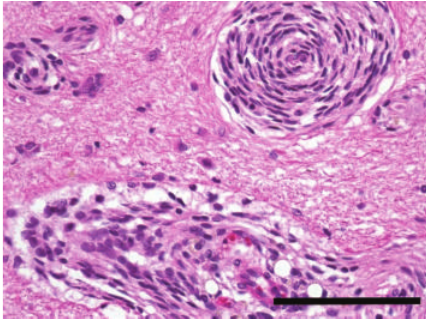
Figure 6: Perivascular wall tumor; right piriform lobe. Higher magnification demonstrating perivascular whorling of proliferative cells. H&E × 600. Bar = 200 𝜇